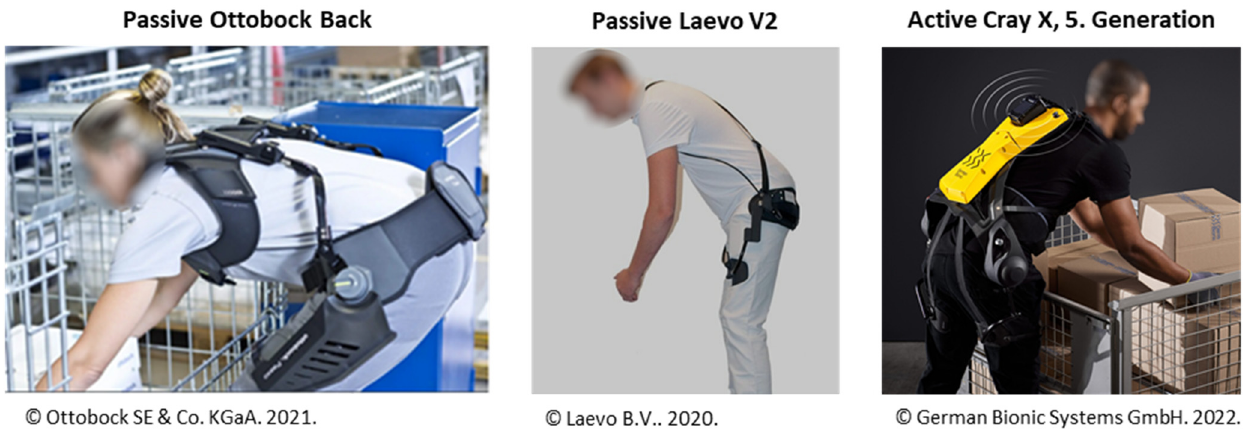
Figure 1. Selection of commercial back-support exoskeletons (BSEs) applying supportive torques aligned with the user’s hips [12,14,17].